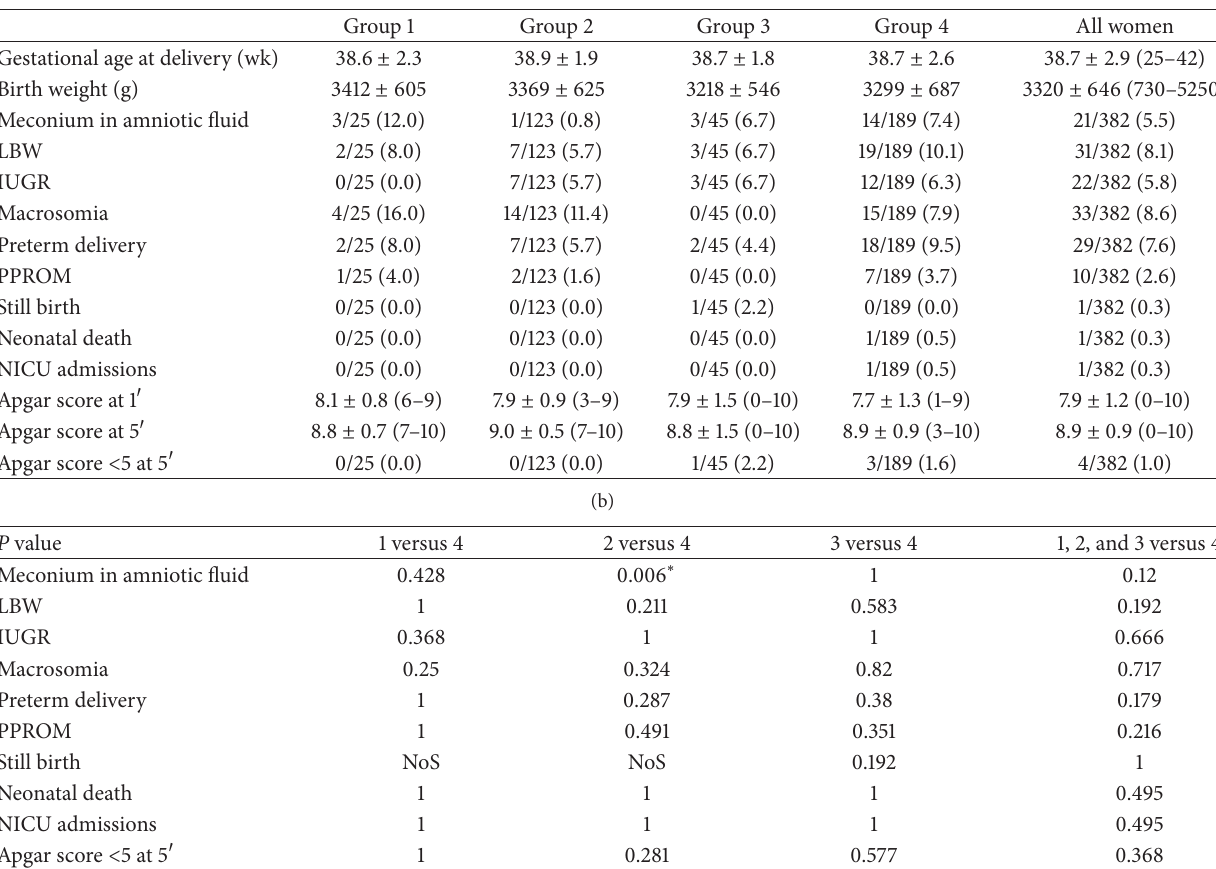
Table 3: Perinatal outcome (%).